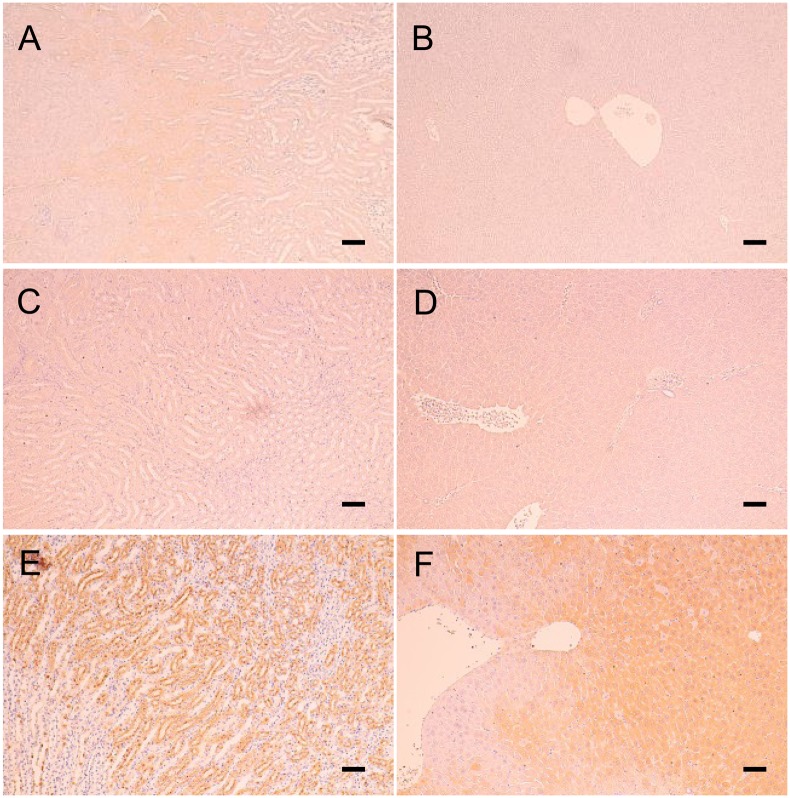
Immunohistochemical staining for HIF-1α in mouse kidneys (A, C, E) and livers (B, D, F) on day 1 after transfusion with HbV/rHSA (A, B), mRBCs/rHSA (C, D), or rHSA (E, F).Bars = 50 μm.